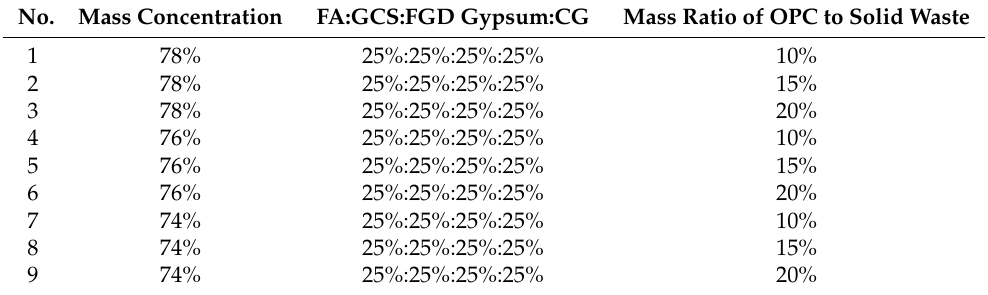
Table 3. Experimental scheme of different mass concentrations and OPC